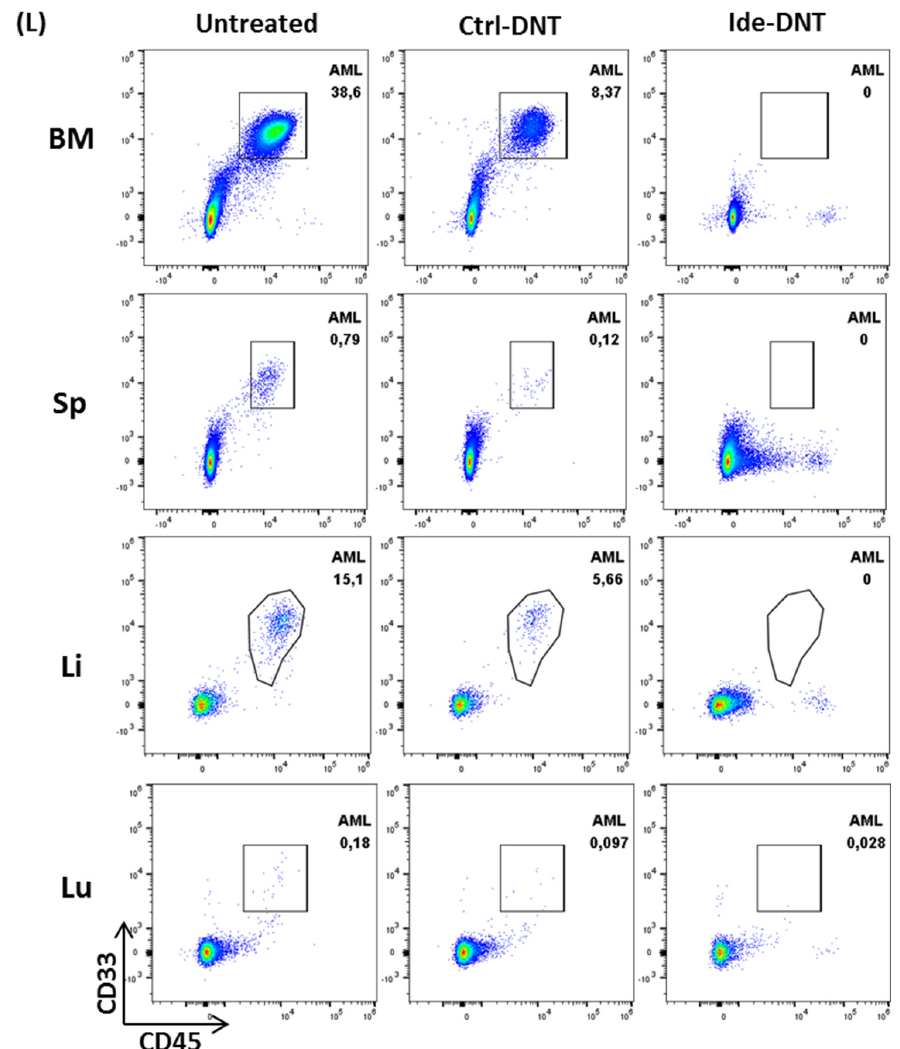
Figure 5. Ide prolongs persistence of DNT and promotes a durable anti-leukemic effect in vivo. ( A ) Schematic diagram of patient-derived xenograft (PDX) model used. Sublethally irradiated NSG mice were infused with 2–3 × 10 6 primary AML patient sample on day 0. On day 17 and 20, mice were infused with 2 × 10 7 ctrl-DNTs or Ide-DNTs. Mice were sacrificed, and DNT persistence and AML engraftment were assessed in various tissues on day 34 or day 100. ( B – E ) NSG mice engrafted with the primary AML sample (090543) were treated with PBS ( n = 8), ctrl-DNT ( n = 8), or Ide-DNT ( n = 9), on day 17 and 20 post AML infusion. Subsequently, ( B ) DNT engraftment in BM (CD45 high CD3 + ), ( C ) the frequency, ( D ) and the number of T CM (CD45 high CD3 + CD45RA − CD62L + ), T EM (CD45 high CD3 + CD45RA − CD62L − ), and T EFF (CD45 high CD3 + CD45RA + CD62L − ), as well as ( E ) the expression level of the exhaustion markers, LAG3, TIM3, and CTLA4, within the DNT population were determined on day 34, which was 14 days post-treatment using flow cytometry. Each dot represents one mouse. The result is representative of 2 similar experiments with different AML primary blasts. ( F – H ) Sublethally irradiated NSG mice were engrafted with primary AML sample (090517), followed by PBS, ctrl-DNT, or Ide-DNT treatment on day 17 and 20. ( F ) Subsequently, the frequency (left) and number (right) of DNTs in peripheral blood were determined between day 21–74 post last DNT infusion in ctrl-DNT and Ide-DNT using flow cytometry. ( G ) Representative flow plots show DNT persistence from peripheral blood on day 94, which was 74 days post-treatment. ( H ) Number of viable DNT engrafted in the bone marrow, spleen, blood, liver, and lung on day 100, which was 80 days post-treatment. Each dot represents one mouse. ( I ) Correlative analysis of DNT and AML cell numbers in the bone marrow (left) and spleen (right) in AML-engrafted mice treated with ex vivo expanded DNTs. The results are representative of three independent xenograft experiments done using AML cell line, MV4-11 ( n = 1), and two primary AML patient samples. ( J ) NSG mice engrafted with the primary AML sample (090543) were treated with PBS, ctrl-DNT, and Ide-DNT on day 17 and 20. Subsequently, the AML level in mice peripheral blood relative to the untreated group was determined on day 45, 52, 58, and 65. ( K , L ) NSG mice engrafted with the primary AML sample (090517) were treated with PBS ( n = 5),